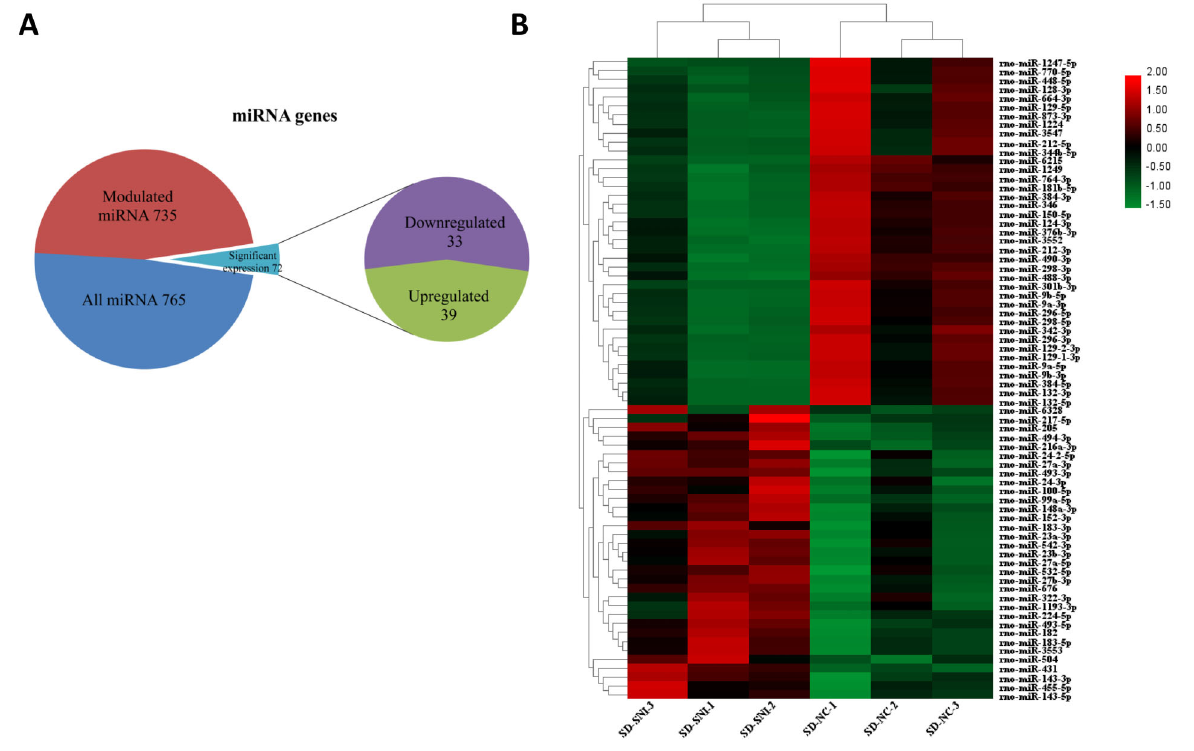
Figure 1. Differentially expressed microRNAs (miRNAs) between spared nerve injury (SNI) rats and sham-operated rats (NC). A , Expression of differentially expressed miRNAs; B , Hierarchical clustering of the differentially expressed